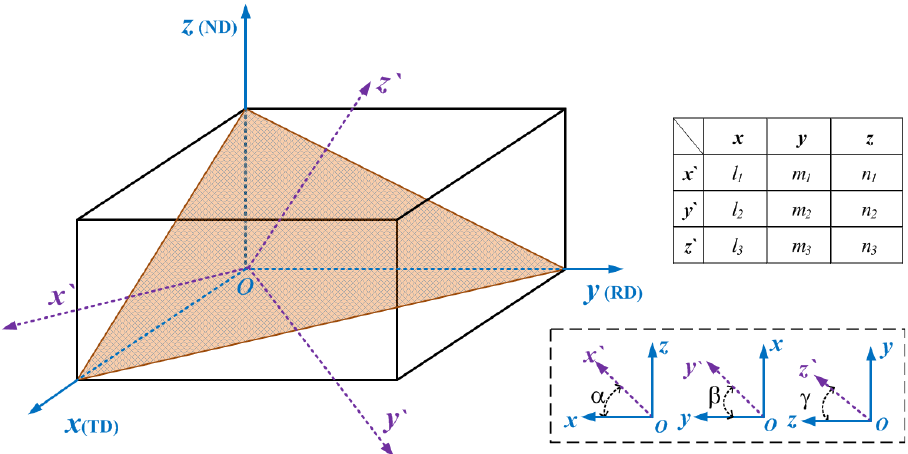
Figure 1. Positional relationship and directional cosine between the axes of the orthogonal and load coordinate systems.